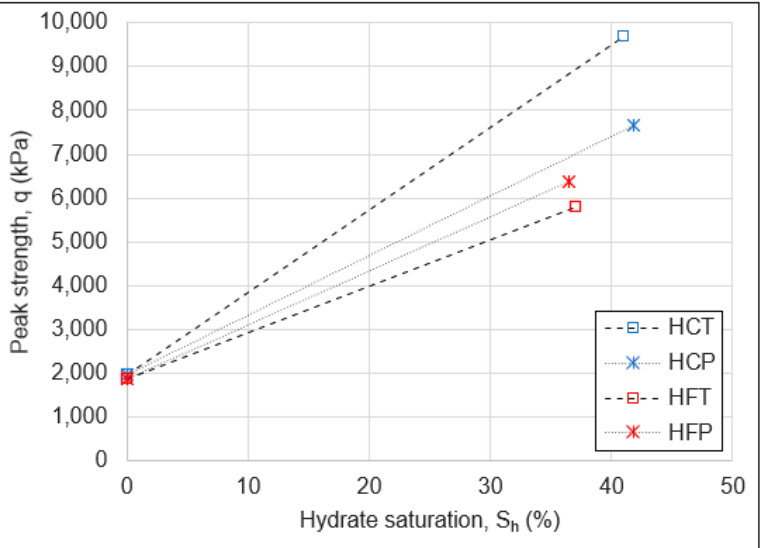
Figure 13. Measured peak strength for all sand specimens including base sands with no hydrate (FS and CS) and hydrate-bearing sand specimens formed using smaller sand particles (HFT and HFP) and larger sand particles (HCT and